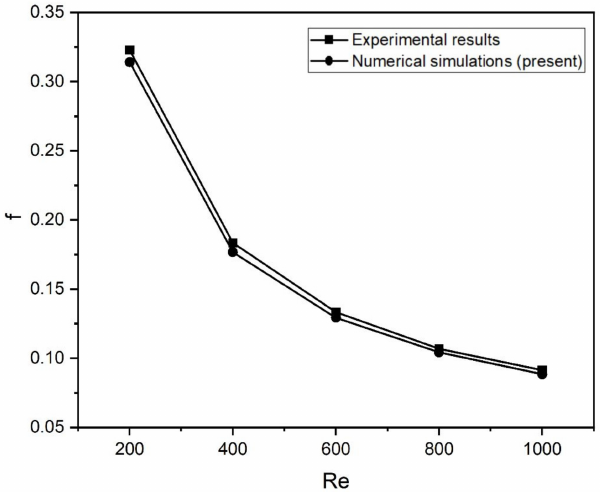
Figure 7. Friction factor ( f ) vs. Re for smooth channel MCHS experimental [5] and numerical.